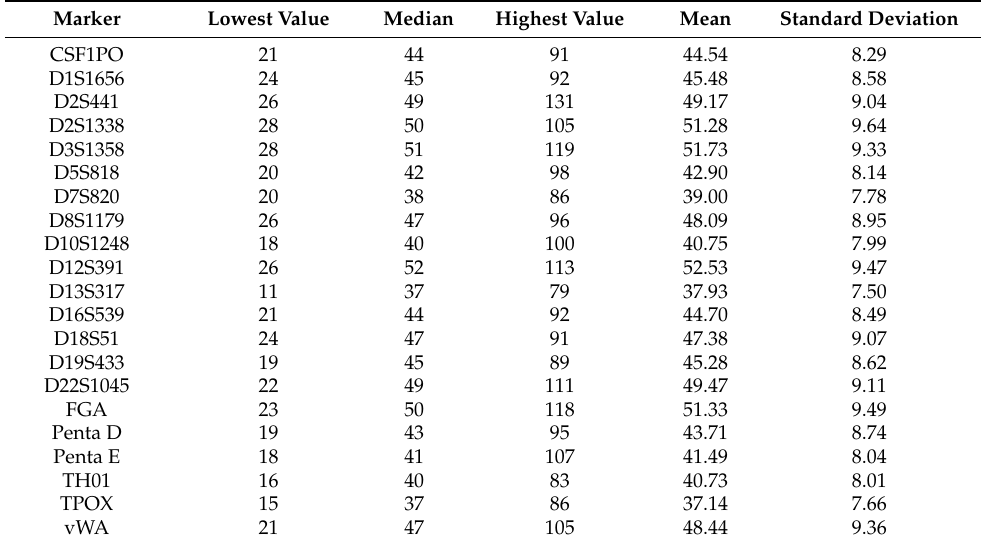
Table 1. Average coverages obtained for each STR marker using the HipSTR